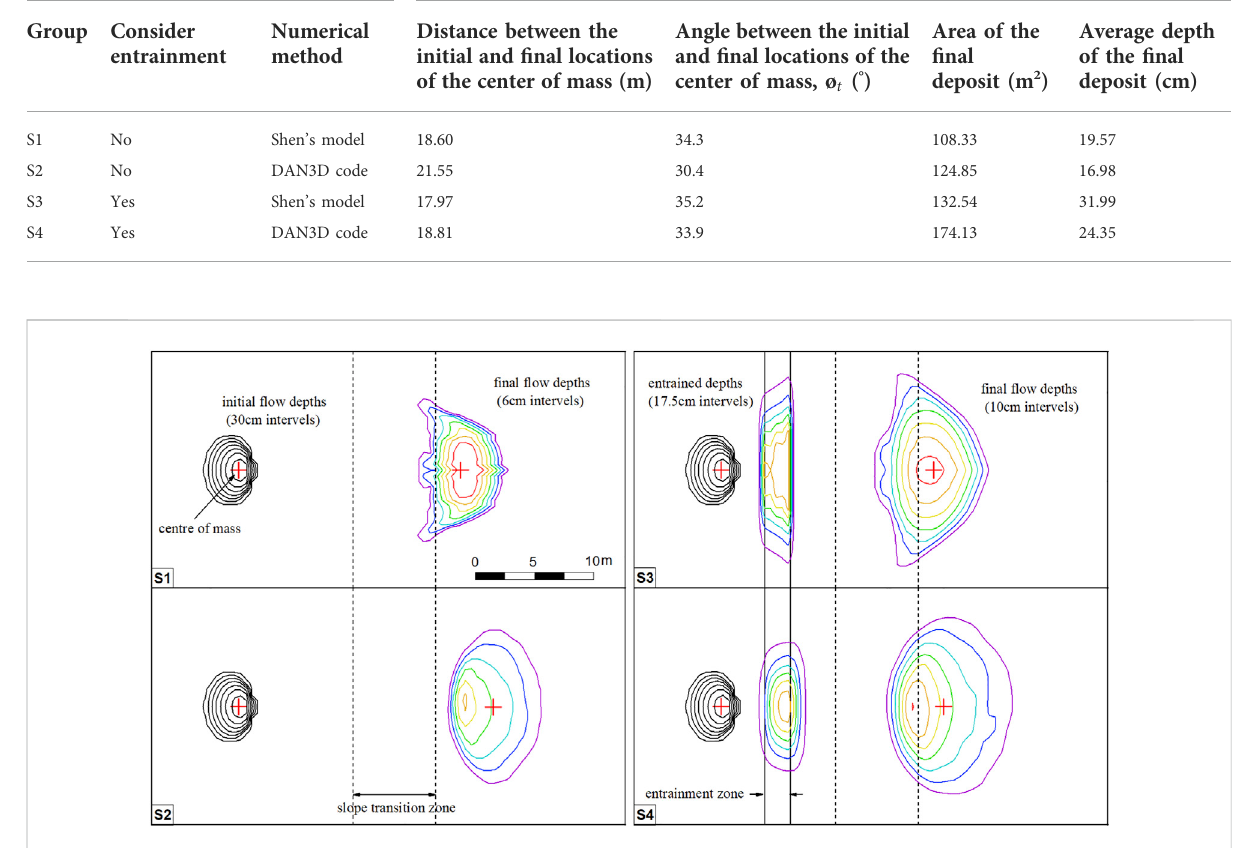
FIGURE 2 Final deposit characteristics of four hypothetical